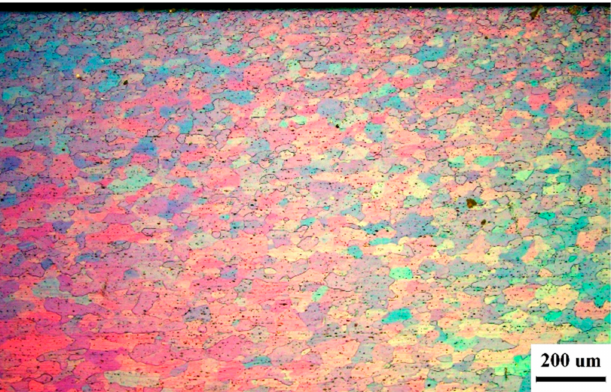
Figure 1. The polarization structure of the 5056 aluminum alloy extruded rod of ϕ 9.5 mm after planing along the axis direction.